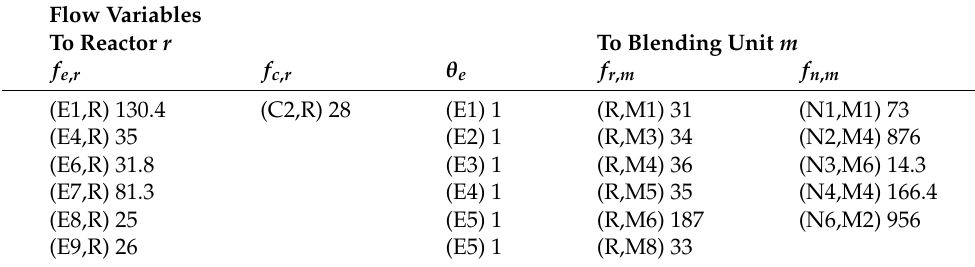
Table 1. Optimal operation decisions on flow rates for Case